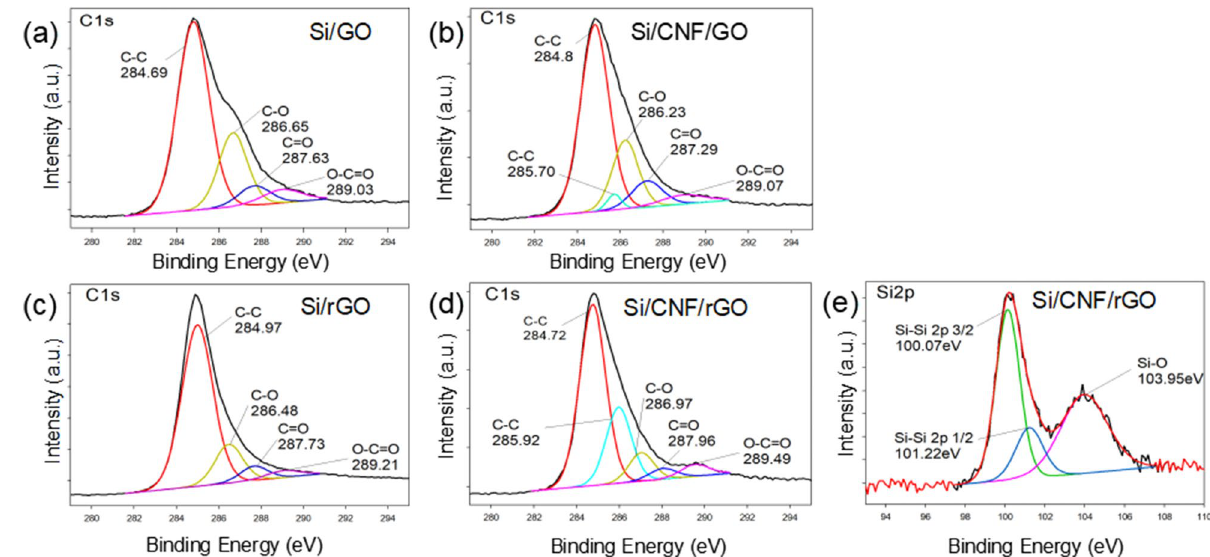
Figure 5. C 1 s XPS spectra of ( a ) Si/GO, ( b ) Si/CNFs/GO, ( c ) Si/rGO, and ( d ) Si/CNF/rGO. ( e ) Si 2p XPS spectrum of